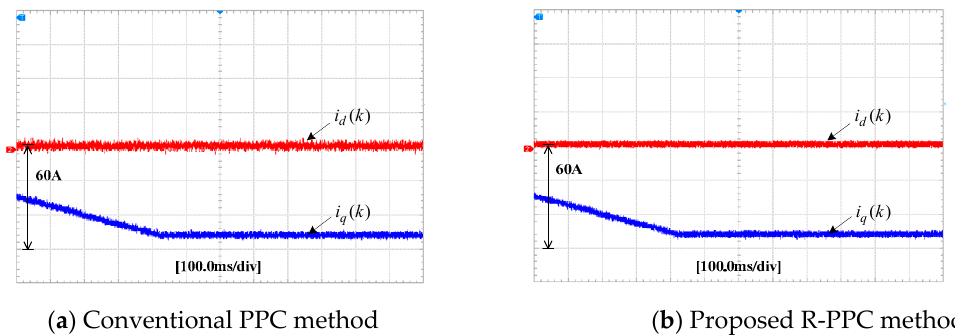
Figure 18. Experimental results of the d- and q-axis current under the discharge state. ( a ) Conventional PPC method; ( b ) Proposed R-PPC method.